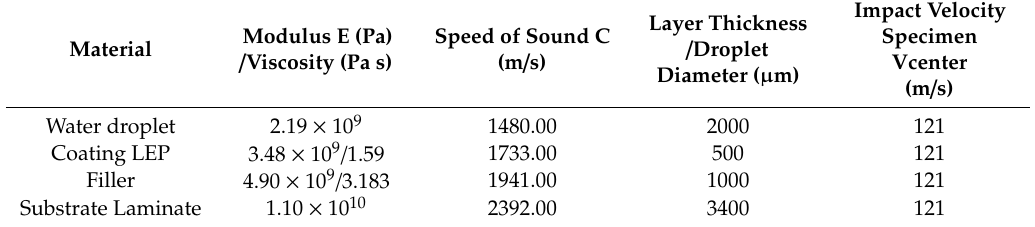
Figure 13. ( a ) Reference multilayer configuration for RET coupons. Liquid droplet and each material layer are defined by the input mechanical parameters of Table 1; ( b ) corresponding numerical configuration outline implemented in OpenModelica.